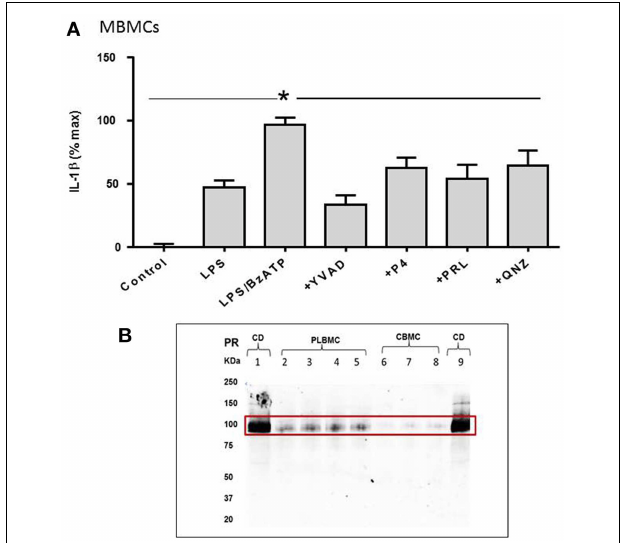
FIGURE 6 | IL-1 β release from maternal blood mononuclear cells (MBMCs). (A) Coincubation with LPS and BzATP elicited greater production of IL-1 β from MBMCs. P4, prolactin, the NFkB inhibitor QNZ and the caspase-1 inhibitor YVAD-CHO all inhibited IL-1 β release. (B) Western blotting showed positive expression for the P4 receptor in choriodecidua (CD; n = 6 ), some expression in PLBMCs ( n = 6 ) but undetectable levels in CBMCs ( n = 6 ). * P < 0.05 when compared using Dunnett’s